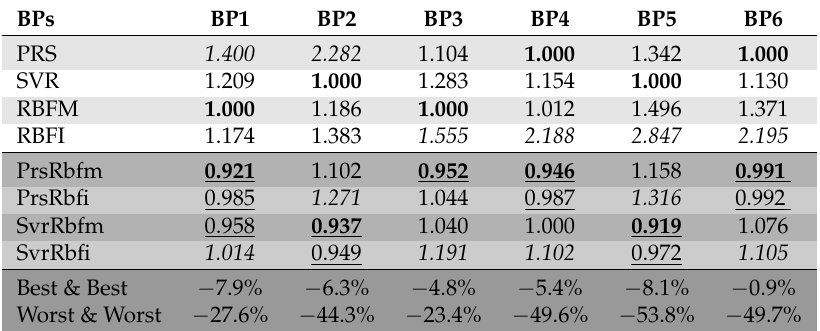
Table 7. Normalized means of RMSE of the metamodels for each benchmark problem with 7 ( k + 1 )( k + 2 ) training points.